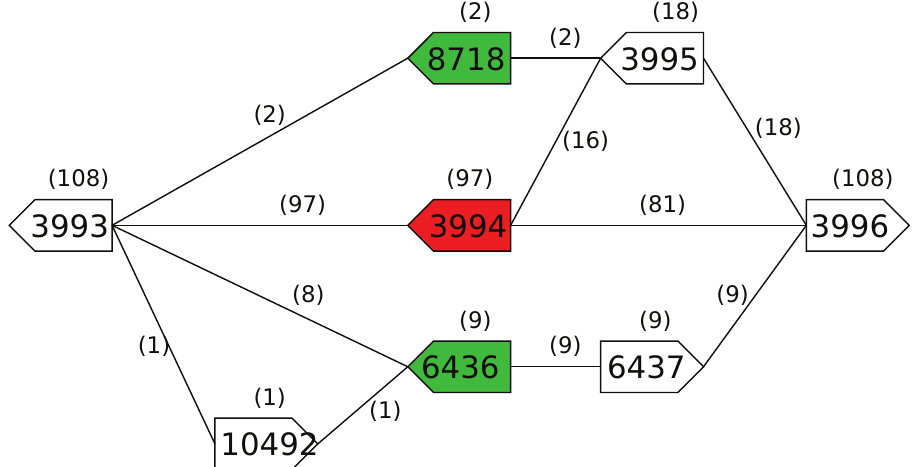
Figure 3. Region of the B. subtillis refined PGG encompassing the variation in the rodA gene across the pan- genome. OGC3994(red)containstherodAgenefromthereferencestrain.ThemedoidsequencesofOGCs6436and 8718 (green) have RefSeq annotations of rodA and full-length homology below our 90% threshold to the medoid sequence for OGC 3994. The arrow boxes represent OGCs with gene directionality indicated by the 5 0 end being